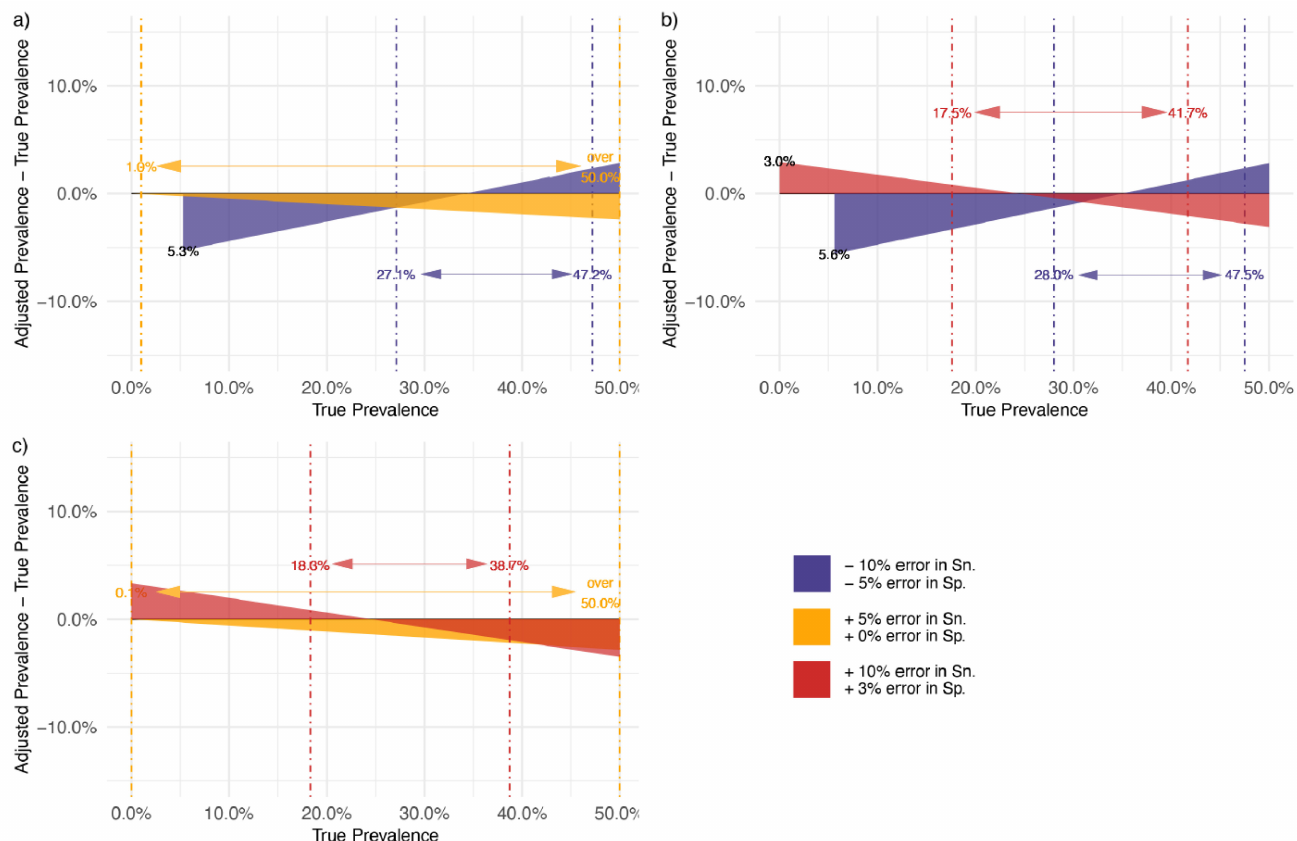
Figure 3. Consequences of correcting seroprevalence estimates using biased estimates of sensitivity (Sn.) and specificity (Sp.): simulation-based analysis. Serological assay with ( a ) high: a true Sn. at 95.0% and a true Sp. at 99.0%, ( b ) good: a true Sn. at 90.0% and a true Sp. at 97.0%, ( c ) and moderate performance: a true Sn. at 80.0% and a true Sp. at 87.0%. Note: The dot–dash lines provide an interval which indicates the seroprevalence adjusted for the mis-specified assay performance at a given error level was still within ± 5% deviation of the true seroprevalence. The prevalence adjustment was performed using the formula by Sempos and Tian [20]. Notice that an assay with underestimated Sn. and Sp. is unable to provide prevalence estimates after adjustment at a low prevalence setting: ( a ) 5.3% and ( b ) 5.6%. An assay with overestimated Sn. and Sp. tends to inflate seroprevalence after adjustment when the true prevalence is low: ( b )